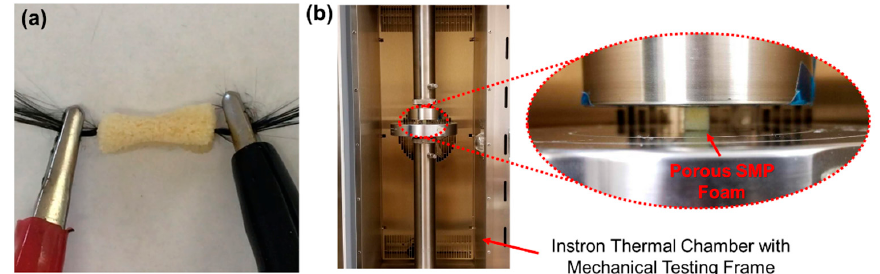
Figure 2. ( a ) Experimental photo of the electrically-heated procedure to activate the shape recovery of the SMP foam using carbon fiber wires. ( b ) Image of the experimental setup in thermal chamber for mechanical characterization of the SMP foam.